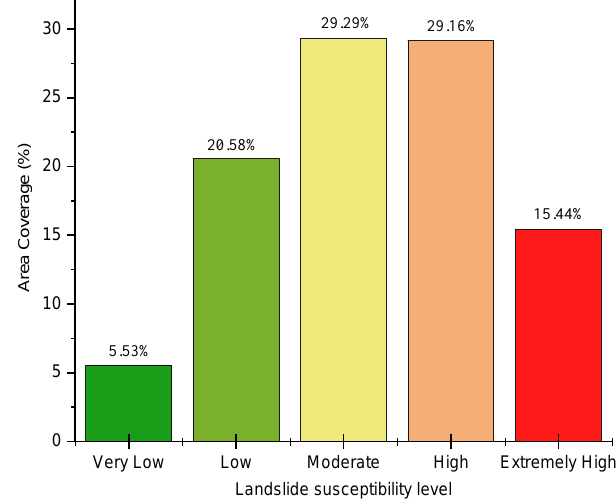
Figure 6. Area coverage of the five landslide susceptibility levels in Kenya.